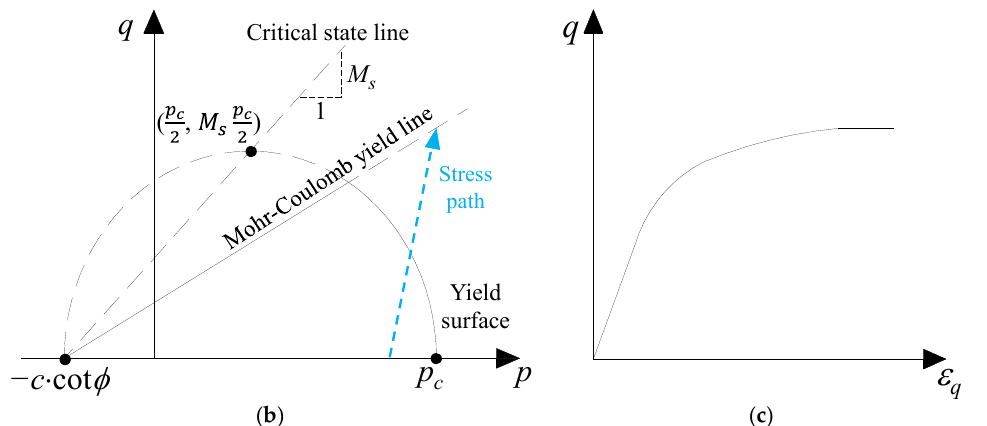
Figure 3. Schematic presentation of the Soft Soil model: ( a ) logarithmic relation between the volumetric strain and mean stress; ( b ) yield surface in p – q space; ( c ) stress–strain relationship.